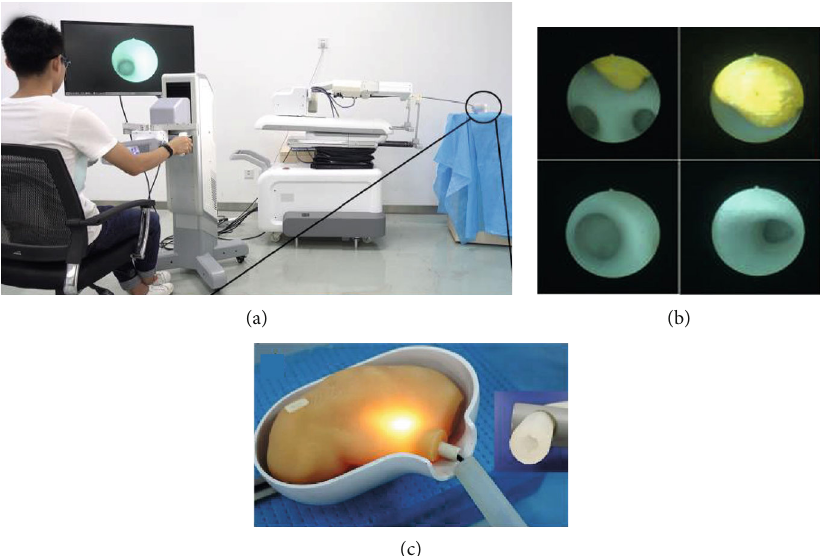
Figure 12: Setup of the phantom experiment: (a) robotic operation of one volunteer; (b) fi eld of view of the fl exible ureteroscope; (c) the phantom utilized in the